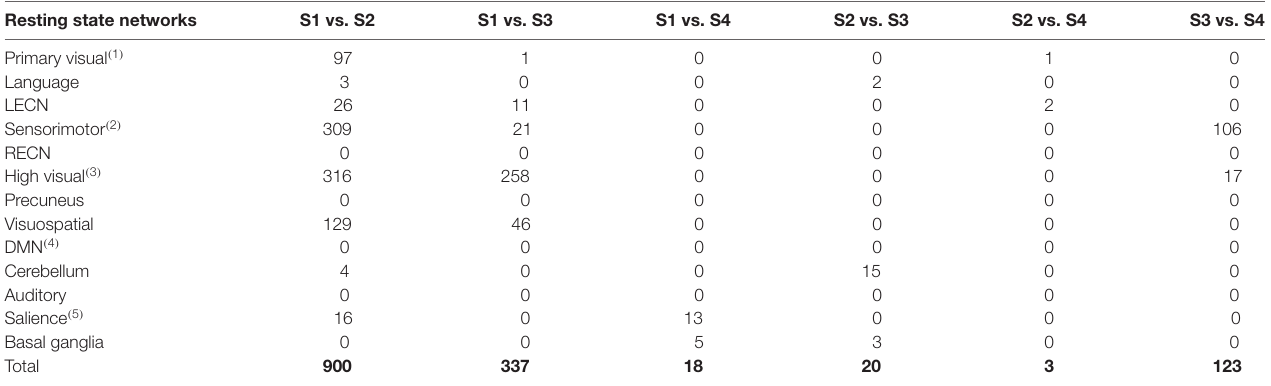
TABLE 5 | Voxel count for motion-corrected dual regression analyses. Resting state networks